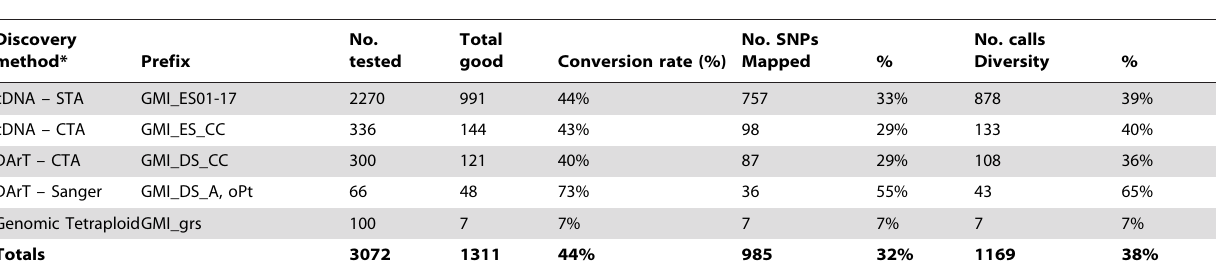
Table 1. Summary of SNPs by marker discovery method.